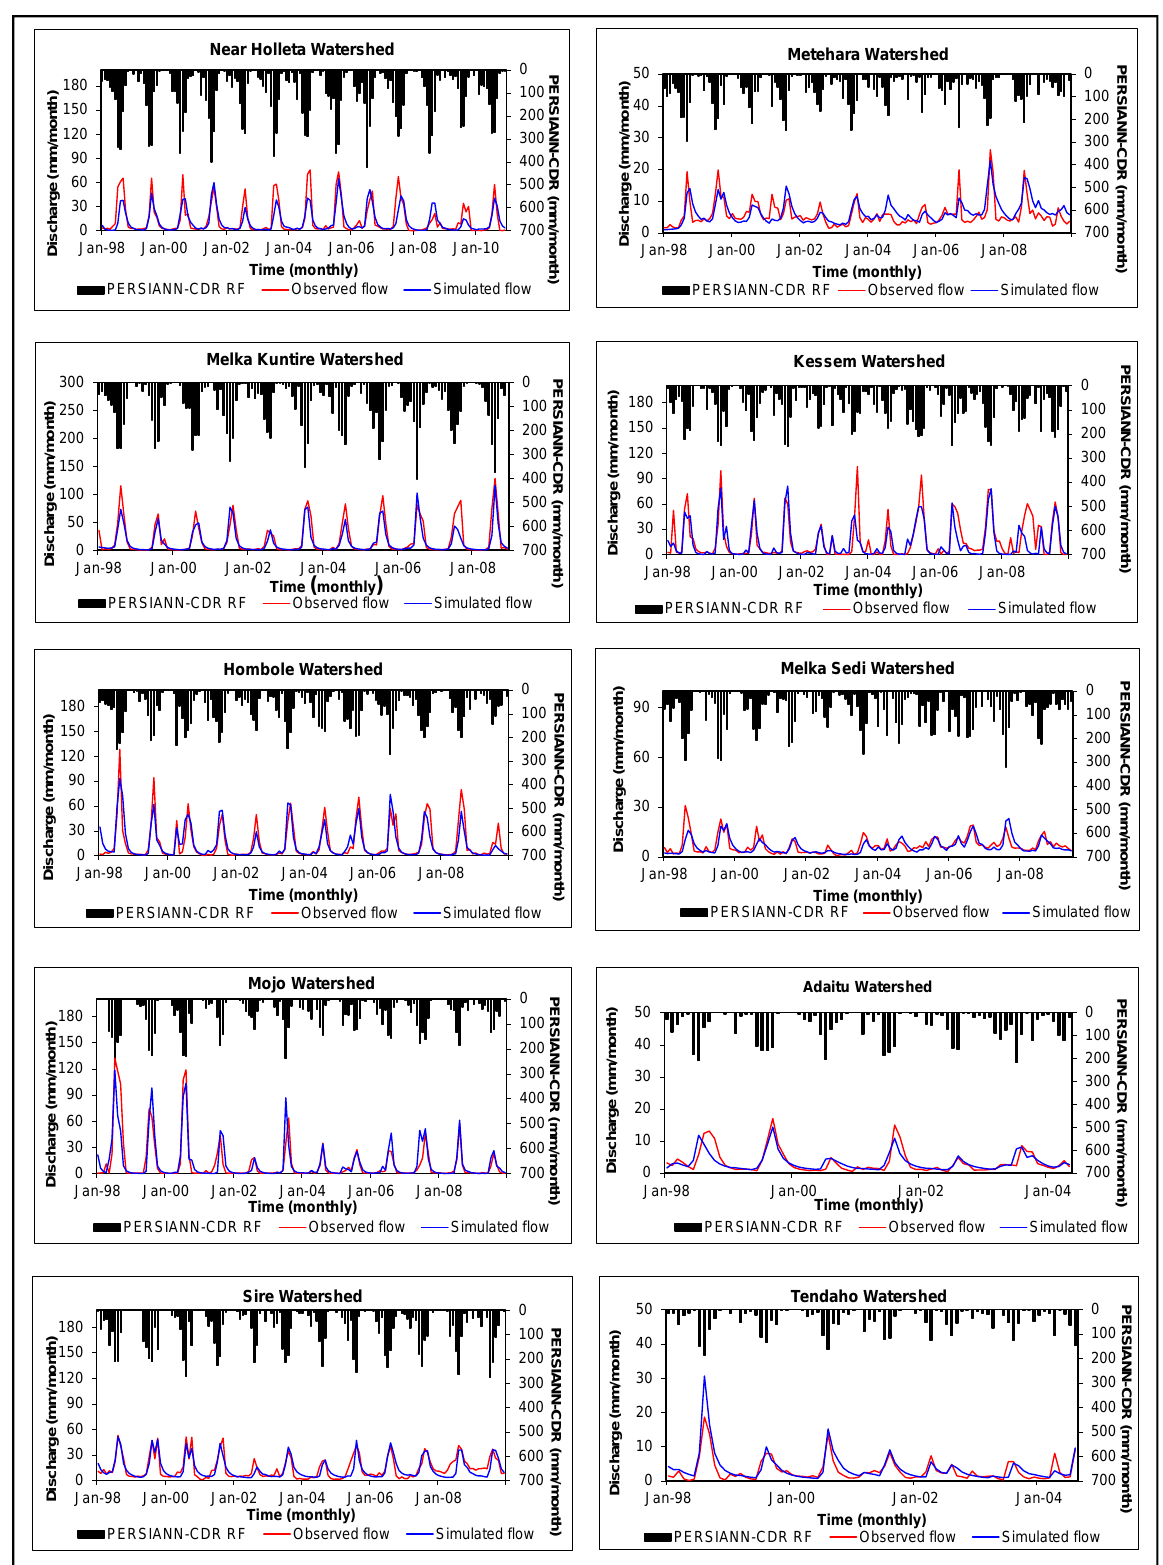
Figure 9. Calibration and validation procedure using Precipitation Estimation from Remotely Sensed Information using Artificial Neural Networks-Climate Data Record (PERSIANN-CDR) rainfall and gauged streamflow records of the ARB.